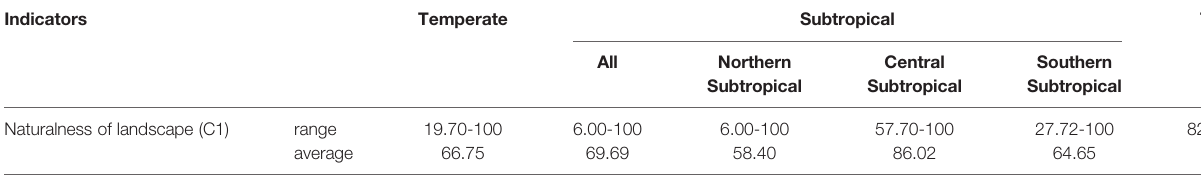
TABLE 6 | Landscape pattern assessment scores.